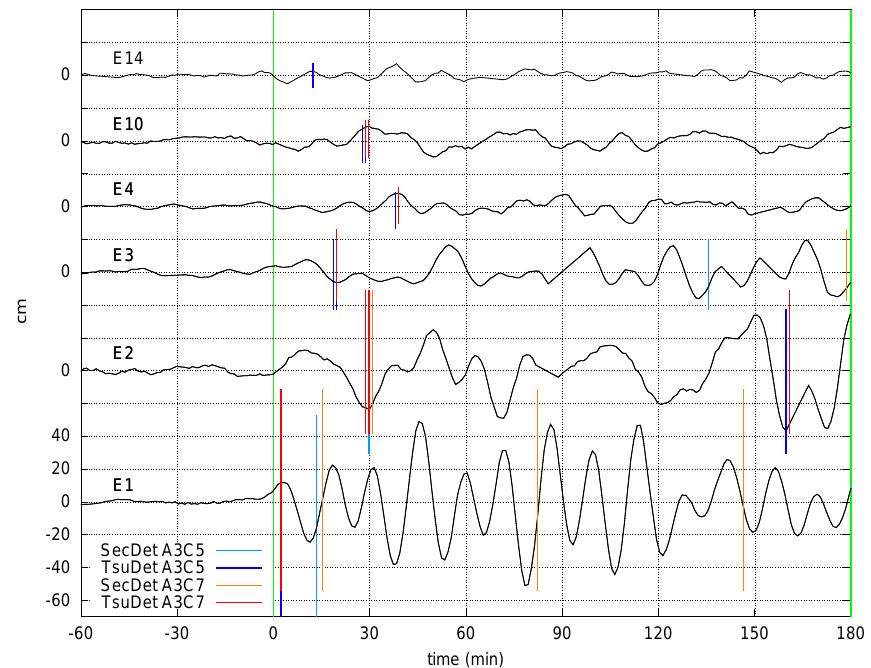
Fig. 8. Comparison of TEDA detections resulting from configurations A3C5 and A3C7 by applying the tsunami detection and the secure detection procedures. All thresholds λ CF belonging to the respective DTR(5) have been considered. Delay Times (DT) (vertical lines) are shown for both TEDA tsunami detections and for TEDA secure detections on the detided records for the six events that are seen by TEDA. The vertical scale is the same in all graphs. Records are plotted for a 4h long interval, including the Detection Window